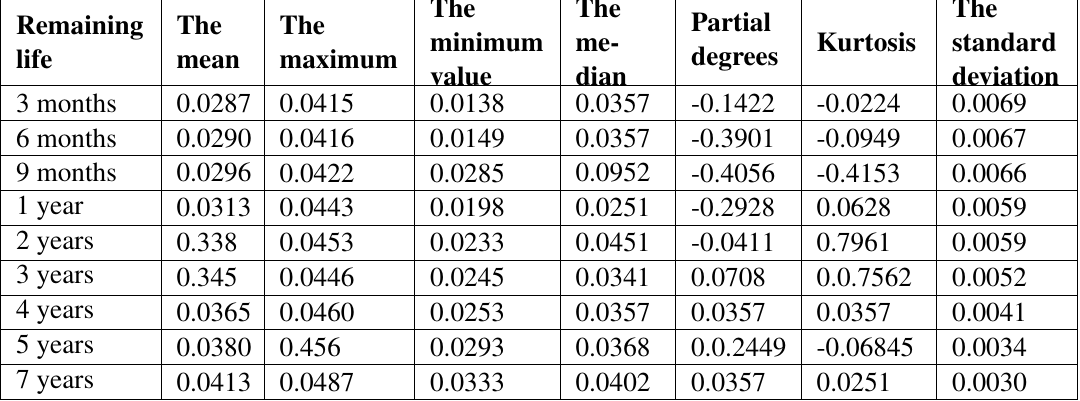
Table 2 Descriptive statistics of government bond